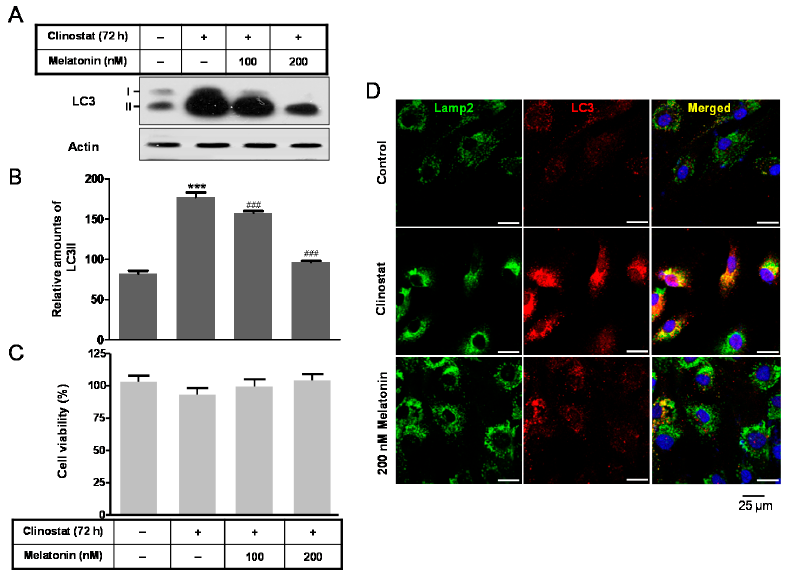
Figure 2. LC3 expression with clinostat rotation and/or melatonin treatment in MC3T3-E1 cells. MC3T3-E1 cells were cultured in α -MEM added with 10% FBS at 37 °C with 5% CO 2 . To experimentally simulate microgravity with the 3D clinostat, cells were cultured in T-25 cell culture flasks completely filled with a 1:1 mixture of α -MEM and Leibovitz’s L-15 supplemented with 10% FBS and 1% PS, with or without melatonin (100, 200 nM). LC3 expression was then performed by Western blot analysis ( A ); the relative expression of LC3 ( B ) was quantified as described in the Materials and Methods section. Immunofluorescence levels of both LC3 and Lamp2 indicate the degree of autophagosomes or autophagy; Cell survival ( C ) was measured and immunofluorescence analysis of LC3, Lamp2; and DAPI staining ( D ) was carried out as described in Materials and Methods. Values in representative results are shown as means ± SD of at least three independent experiments. ( D ) Scale bars, 25 µm. *** p < 0.001 vs. No clinostat. ### p < 0.001 vs. clinostat.